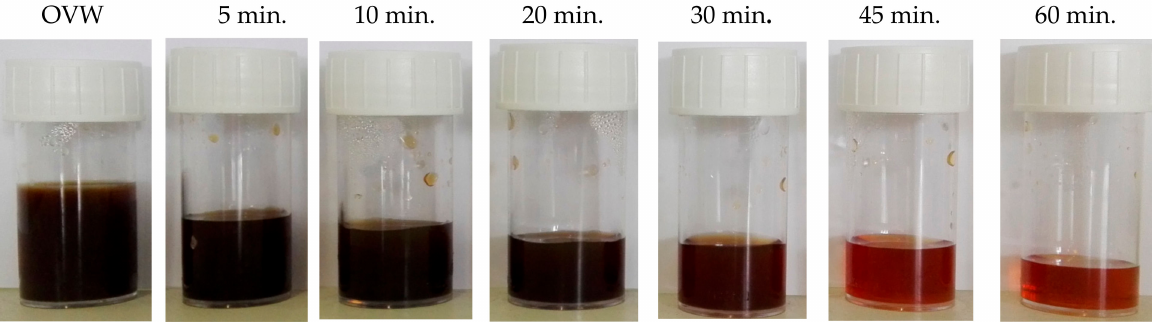
Figure 3. Samples of olive vegetation waters at different adsorption times in the system consisting of 20 mL of OVWs and 1 g